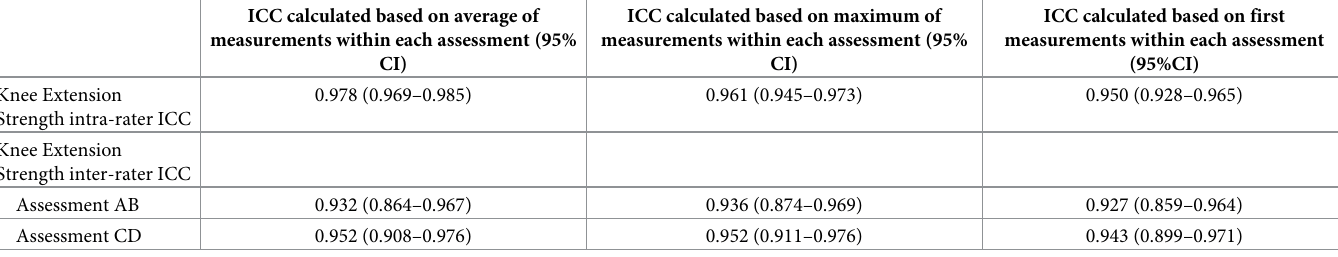
Table 2. Intra-rater and inter-rater intra-class correlation coefficients (ICC) of knee extension strength measured with hand-held dynamometers using average, maximum and first values within AB and CD assessments. ICC calculated based on average of measurements within each assessment (95%